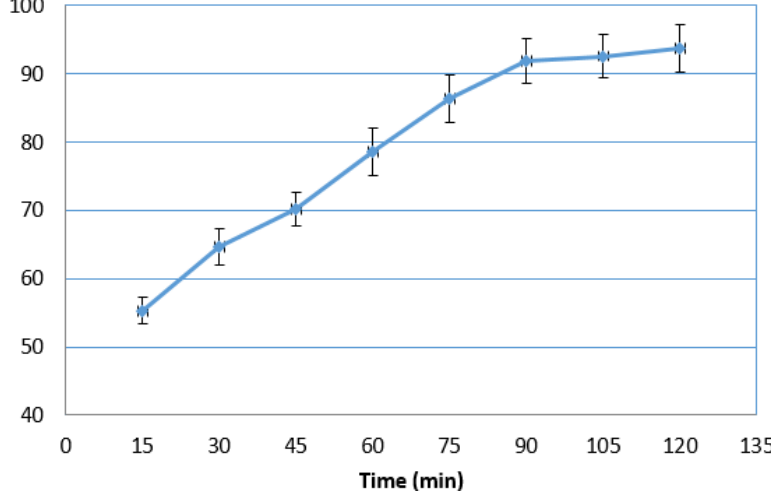
Figure 6. CIP removal percentage using 5 wt% N-TiO 2 during testing under optimal operating con- ditions: initial concentration of CIP = 30 ppm, pH = 5, feed flow rate = 0.4 L/min.